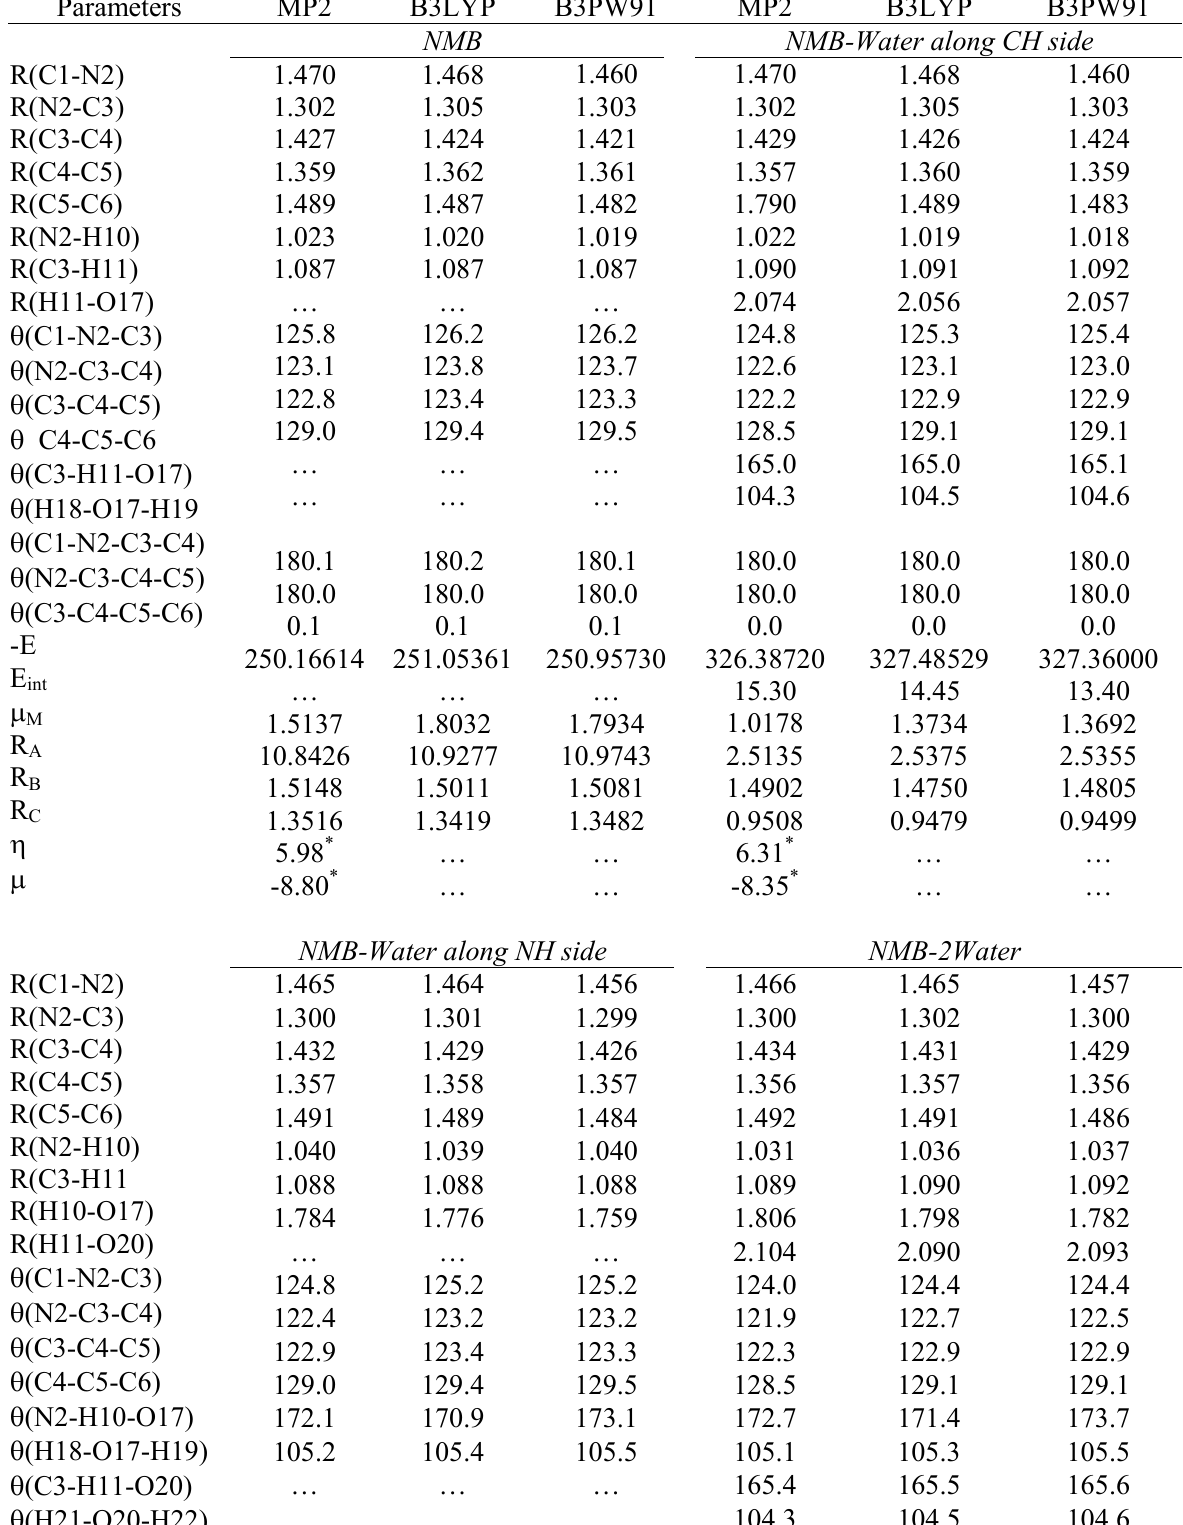
Table 2. Optimized geometrical parameters (bond length in A o , bond angle in degrees), rotational , R , R (in GHz), dipole moment µ constants R A B C energy E (in k cal/mol), chemical potential µ (in eV) and chemical hardness η (in eV) for int and NMB-water